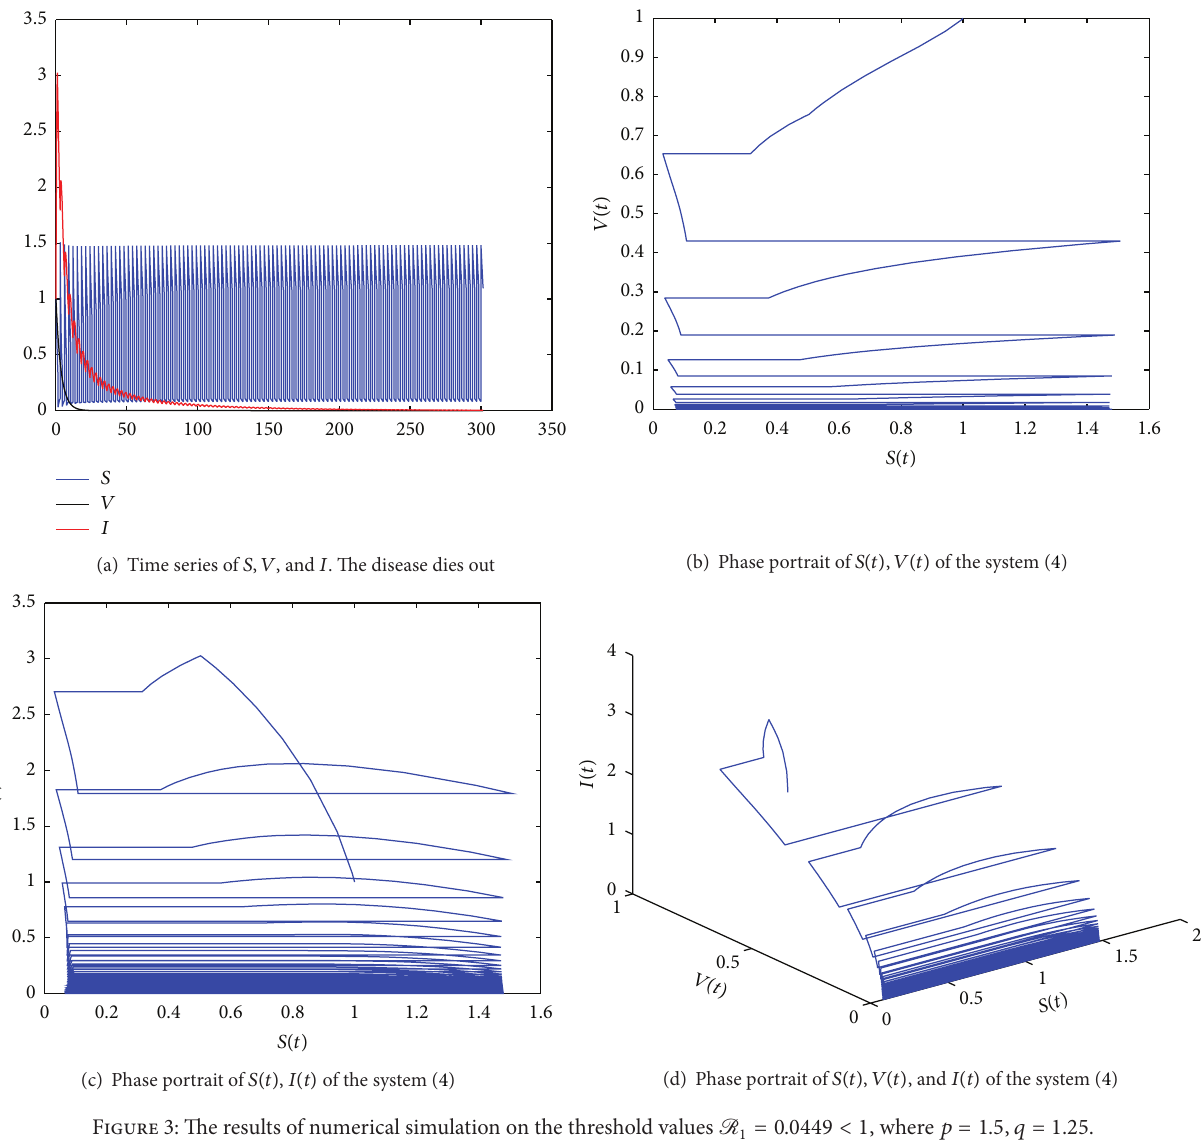
Figure 3: The results of numerical simulation on the threshold values R 1 = 0.0449 < 1 , where 𝑝 = 1.5 , 𝑞 = 1.25